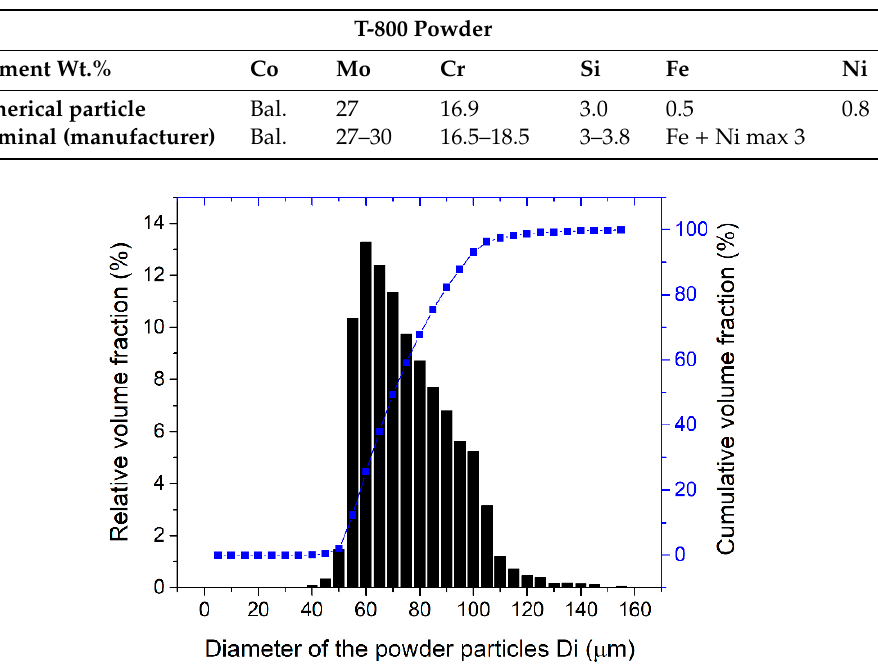
Table 1. Chemical composition of T-800 powder.